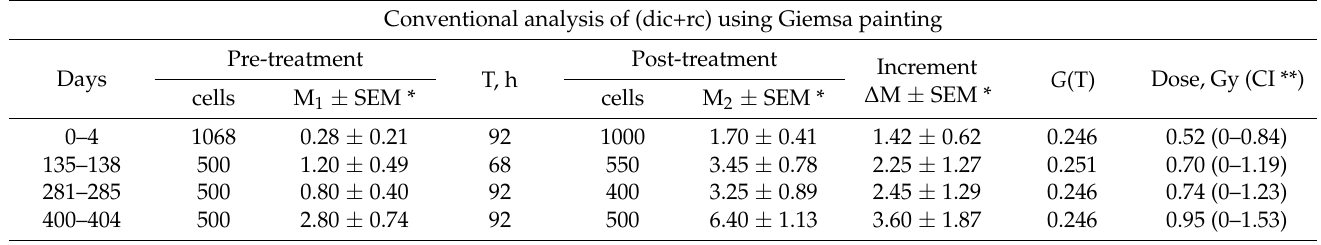
Table 2. The aberration yield and cytogenetic dose estimate for the DTC patients using different cytogenetic assays. Patient